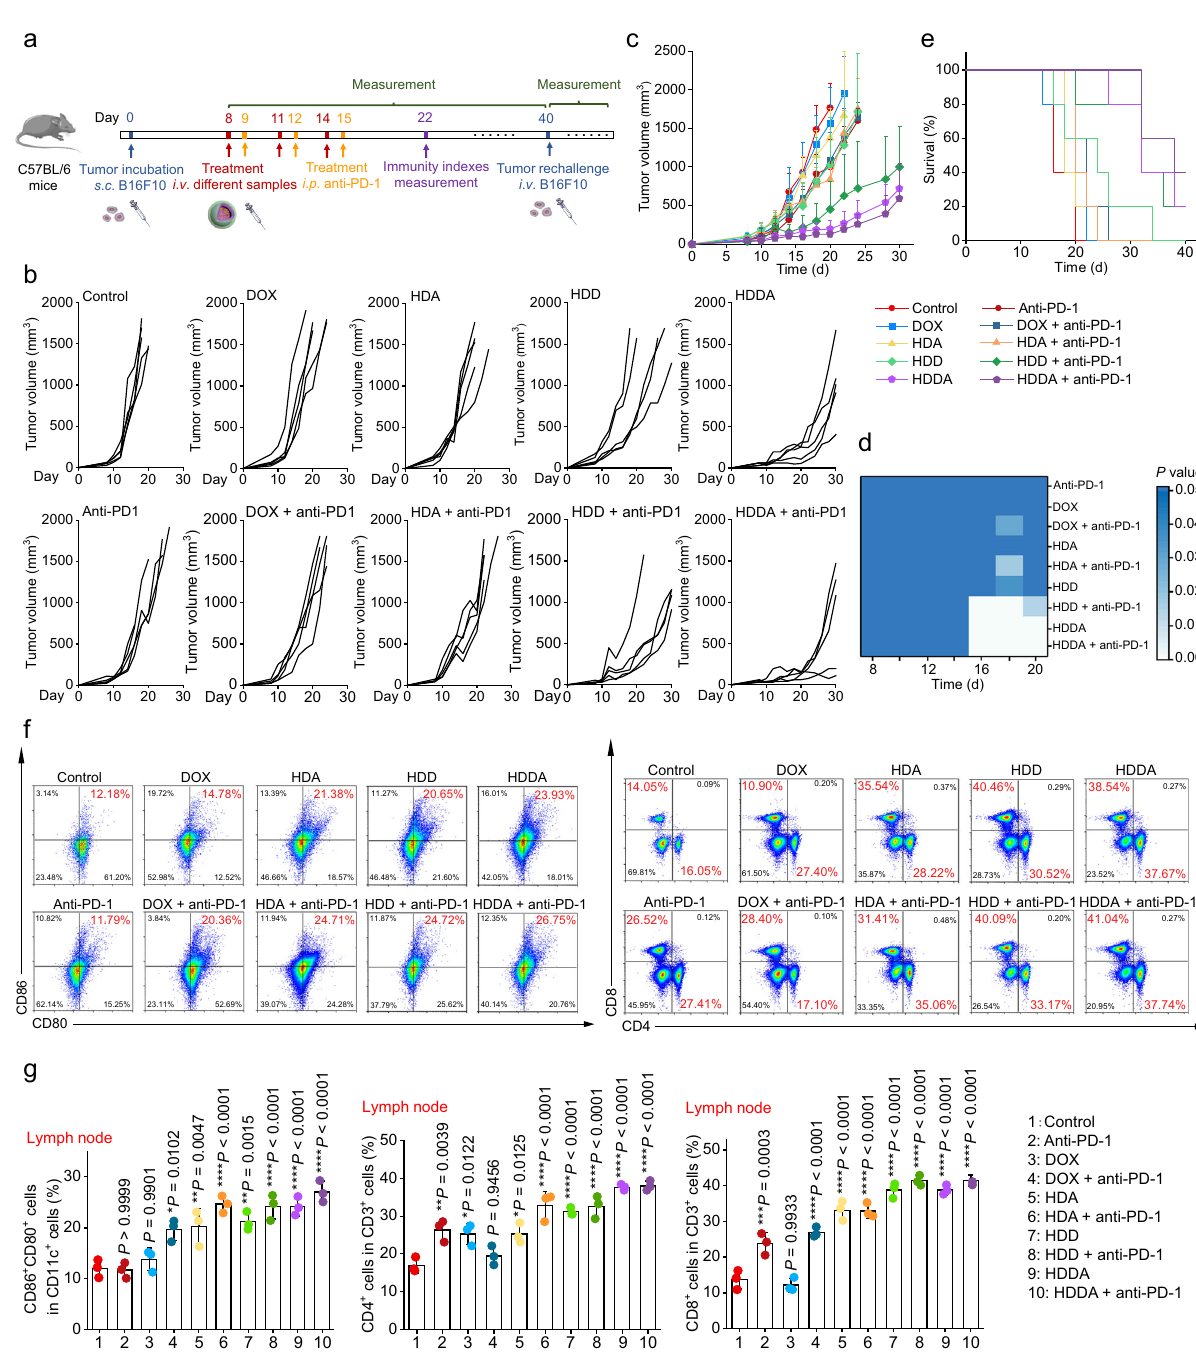
Fig. 8 | HDDA NBs exhibit high antitumor therapeutic ef fi cacy, systemic immune responses, and durable immunological memory in the B16F10 tumor model. a Experimental outline showing the treatment steps and procedures for evaluatingthetherapeuticandimmunostimulationoutcomesofdifferentgroupsin B16F10 tumor-bearing C57BL/6 mice. b Individual B16F10 tumor growth curves of the mice after different treatments. c Average tumor growth curves of the B16F10 tumor-bearing C57BL/6 mice after various treatments and d corresponding heat mapofthe P valuesbetweenthecontrolgroupandothergroups.Themicetreated